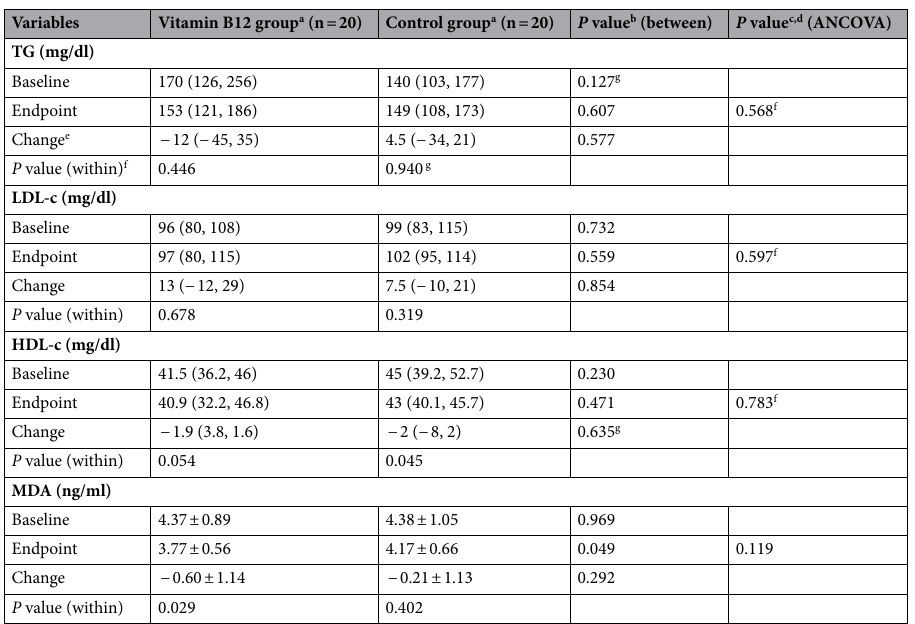
Table 4. Within-group and between-group comparisons of the baseline, endpoint and changes’ values for the study secondary outcomes in vitamin B12 and placebo groups. ANCOVA analysis of covariance, HDL-c high density lipoprotein-cholesterol, LDL-C low density lipoprotein cholesterol, MDA Malondialdehyde, TG triglyceride. a Values are expressed as mean ± standard deviation or median (25th, 75th percentiles). b P -value for comparing the values between the study groups at baseline, at the endpoint and the change from baseline. Two sample t-test and Mann–Whitney U test were used for parametric and non-parametric comparisons, respectively. c P value for ANCOVA test to determine the significant levels of differences between the two groups post-intervention while adjusting for baseline measurements and covariates. d Adjusted for baseline values of corresponding variable, age, and the baseline values of FBG. e Endpoint values minus the baseline ones. f P -value for comparing baseline with end point values within each group. Paired sample t-test and Wilcoxon Paired Rank test were used for parametric and non-parametric comparison, respectively. g P -value obtained from a non-parametric